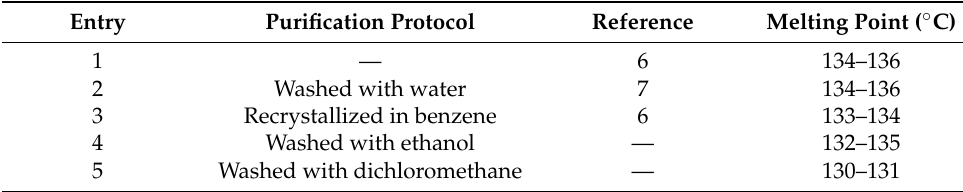
Table 1. Melting points of TSD employing distinct purification protocols a